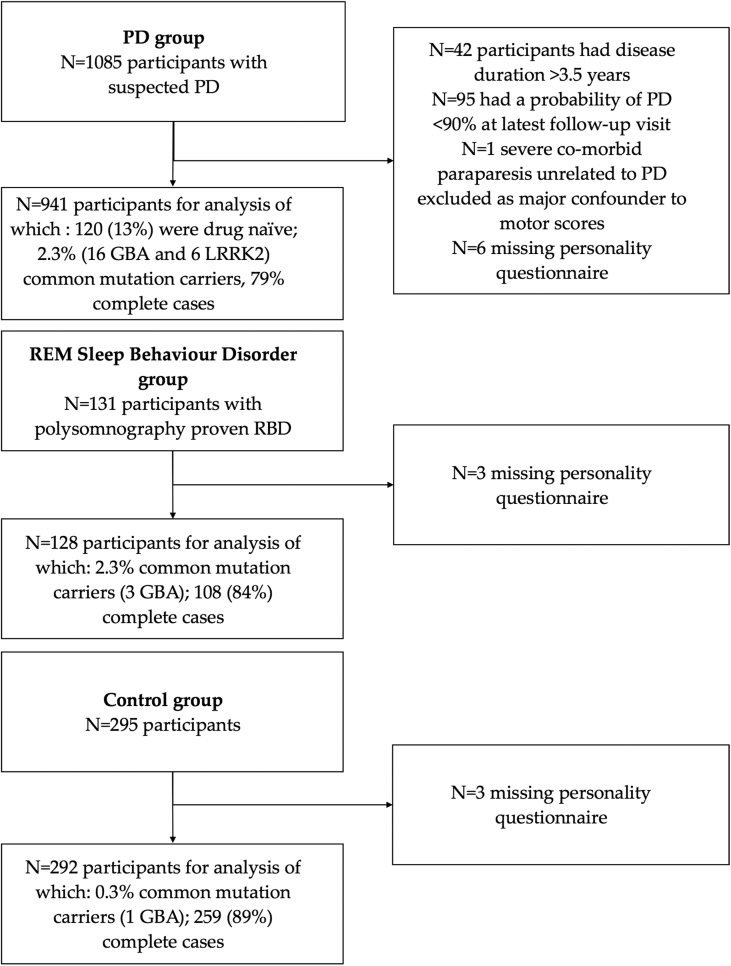
Flow chart of participant inclusion and exclusion.